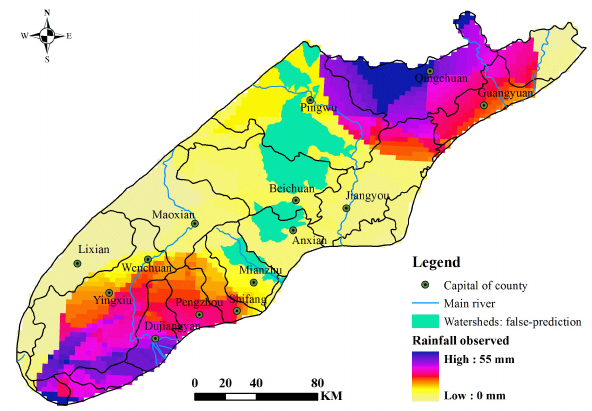
Figure 11. Distribution of observed rainfall for the prediction day in the earthquake-affected